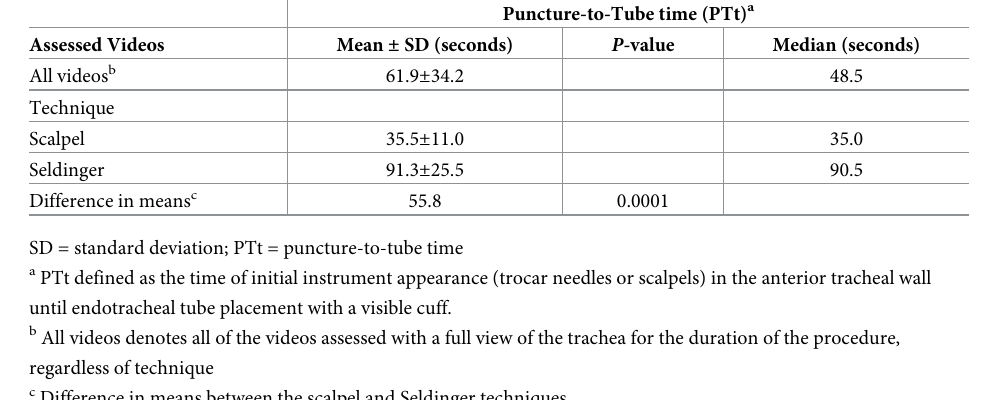
the posterior tracheal wall and was unable to be advanced (not shown; this was the same